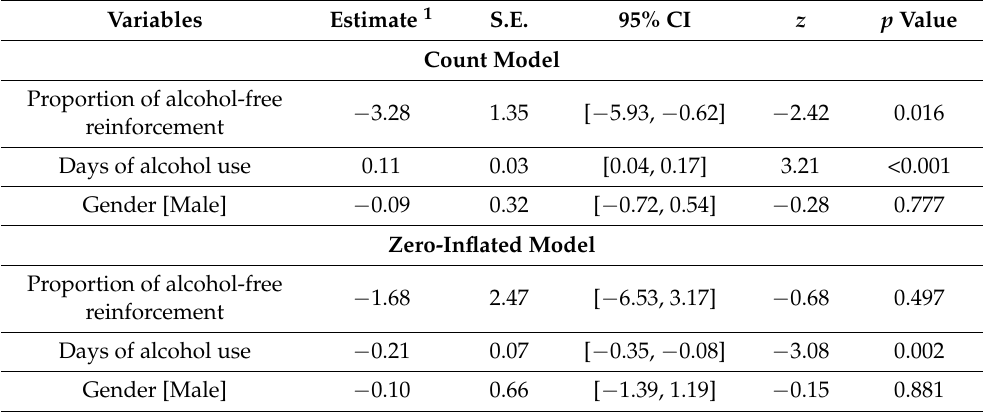
Table 2. Association between proportionate alcohol-free reinforcement and days of alcohol and cannabis co-use.